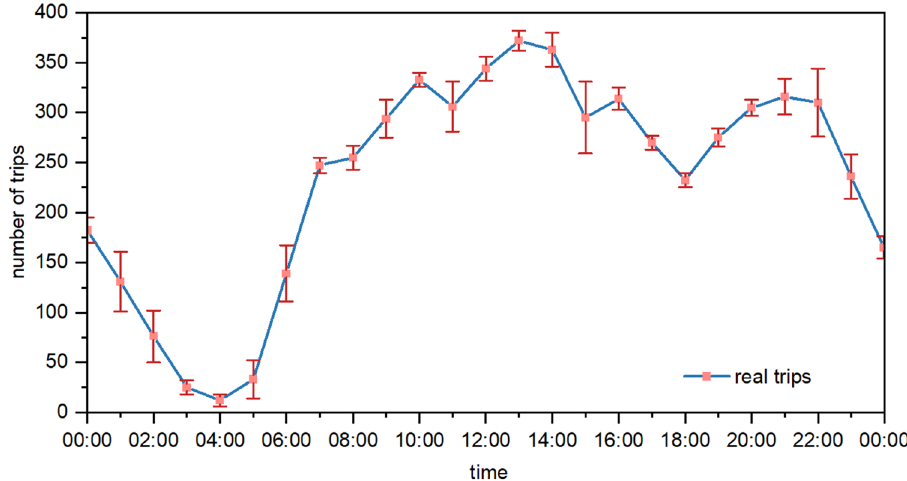
Fig. 5 Number of trips at differ- ent time in one